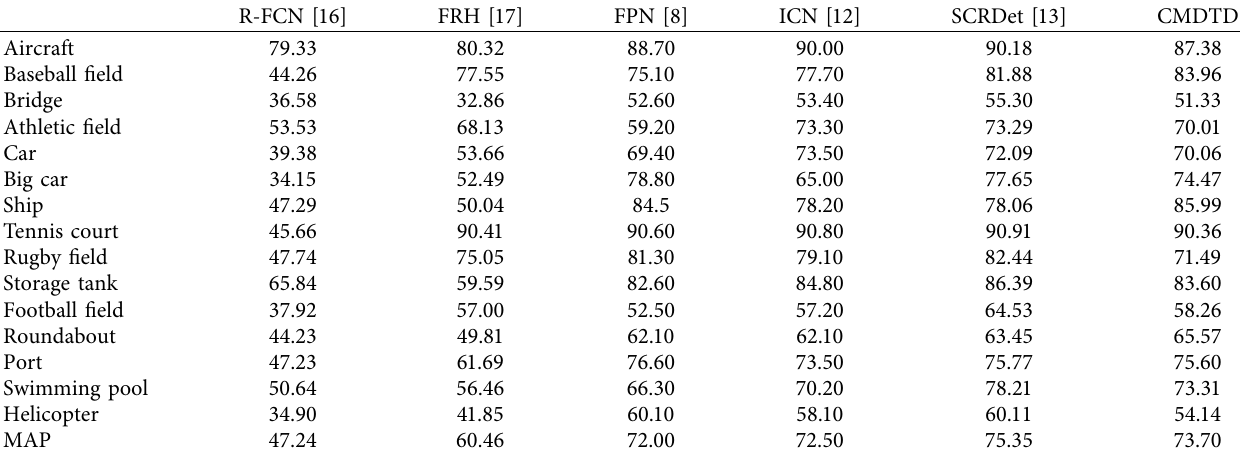
Table 3: Comparison result (%) of DOTA task 2.